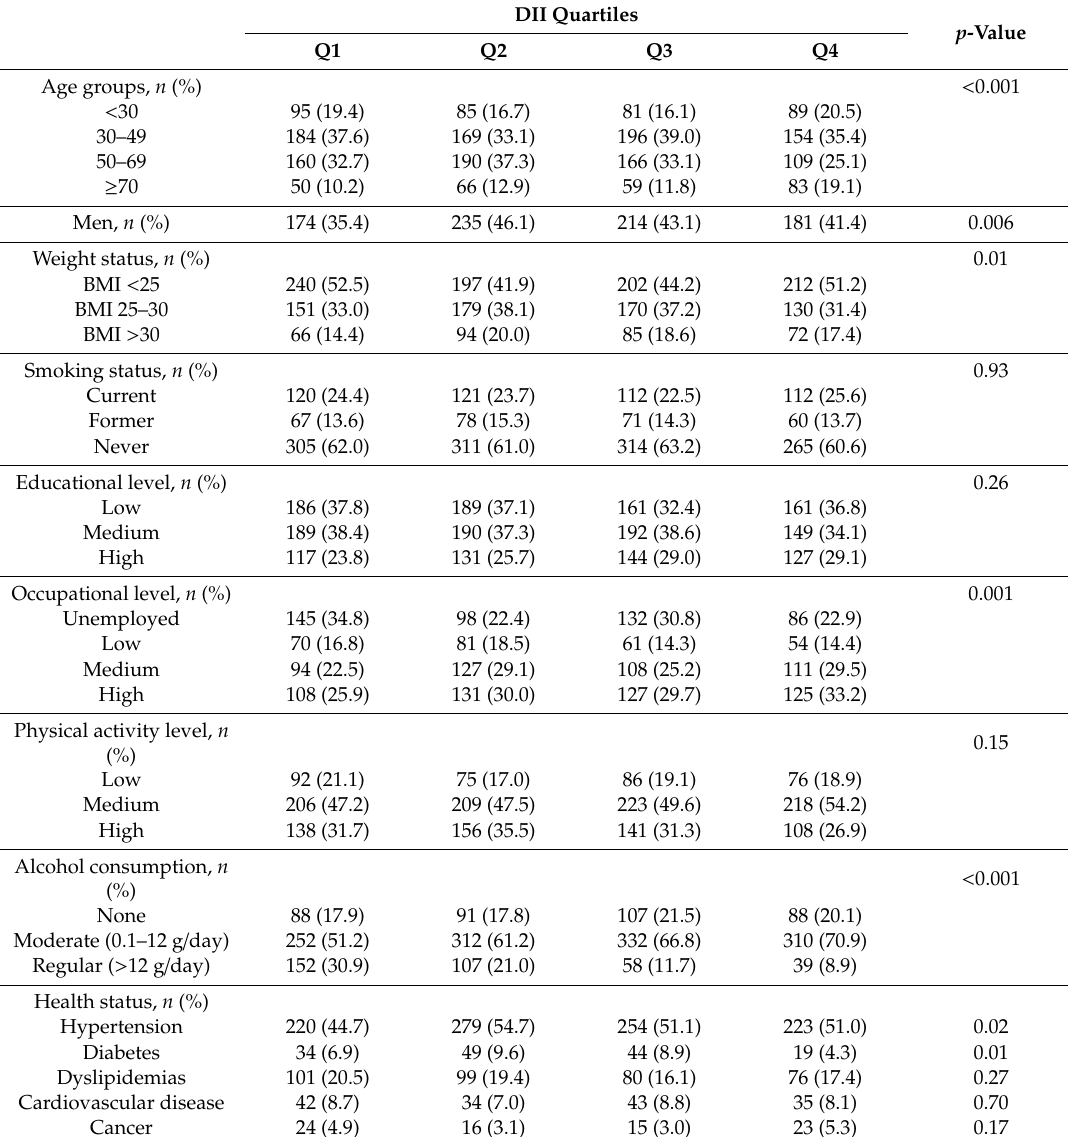
Table 1. Baseline characteristics of the study sample according to Dietary Inflammatory Index (DII)